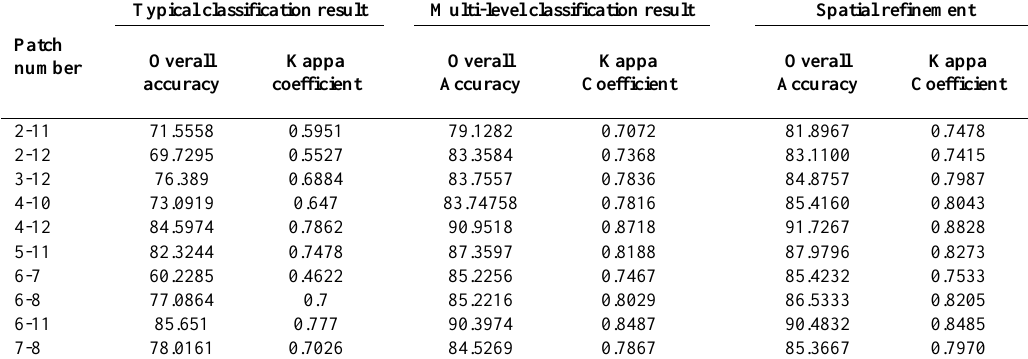
Table 2. Overall accuracy and Kappa coefficient of test patches in the proposed method.